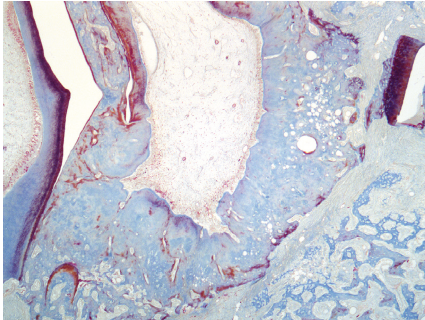
Figure 11: Histological picture of the cross section of the mandible of the rabbit 4 weeks after the formation of a bone defect and introduction of calcium hydroxide suspension.